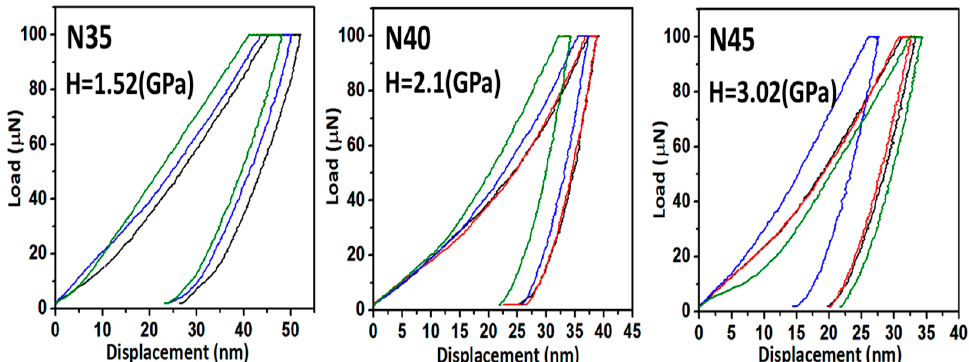
Figure 3. The typical load versus the displacement curves for the CrN films and the average nanohardness values due to different nitrogen-to-argon ratios.